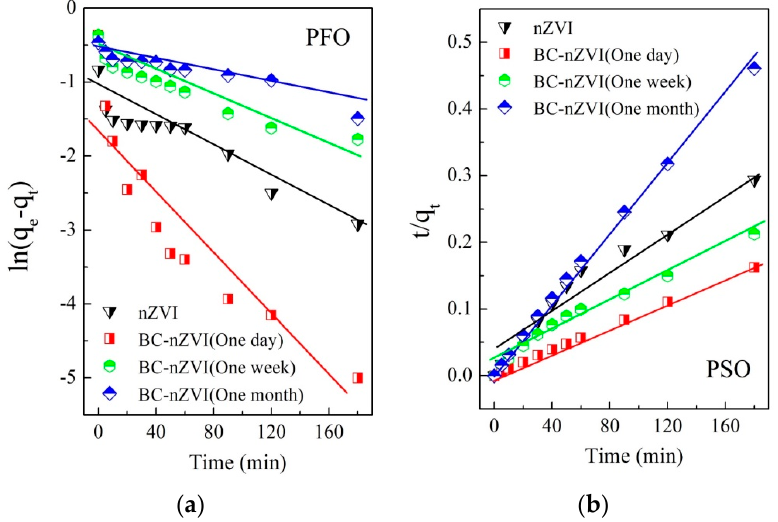
Figure 7. Kinetic analysis of reduction–adsorption of total Cr using pseudo-first-order (PFO) ( a ) and pseudo-second-order (PSO) ( b ). Table 1. Kinetic parameters for total Cr removal.